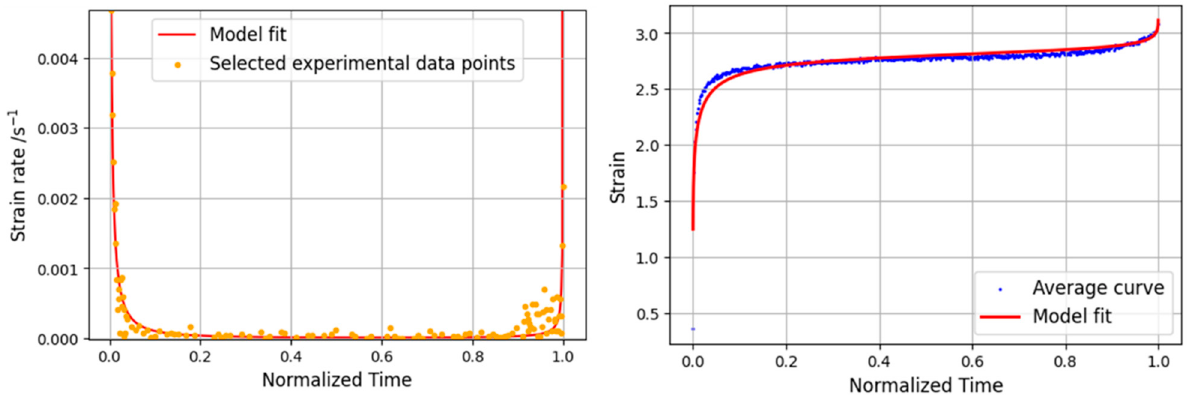
Figure 14. Analytical and experimental strain rate curve ( left ) and static creep curve ( right ) for 30% load level.